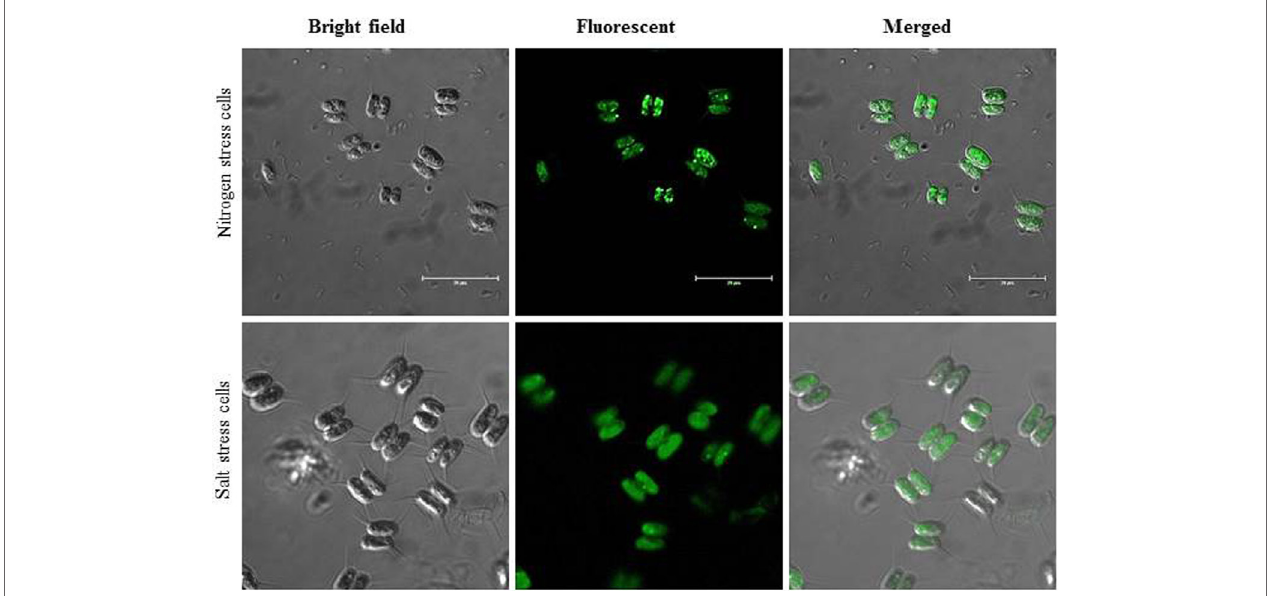
FigUre 1 | immunostaining lipid body structural protein fluorescent images under nitrogen-starved and salt stress cells . Scale bar represent 20 μ m in each